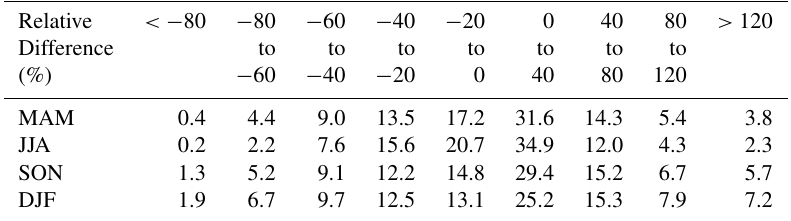
Figure 2. Time series of daily mean PM 2 . 5 concentrations in the 28 pollution channel cities from January to March 2019 (units: µgm − 3 ). Table 1. Frequency of the relative day-to-day PM 2 . 5 difference within the specific